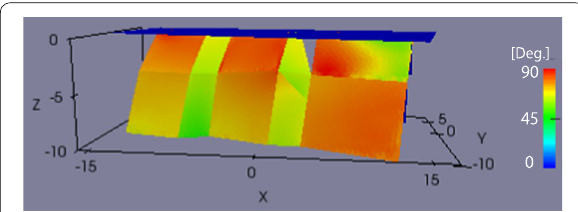
Fig. 13 Spatial variations of the slip direction for Model S. The motion of the hanging wall relative to the foot wall is shown where the reverse and sinistral motions correspond to 90° and 0°, respec- tively. View from